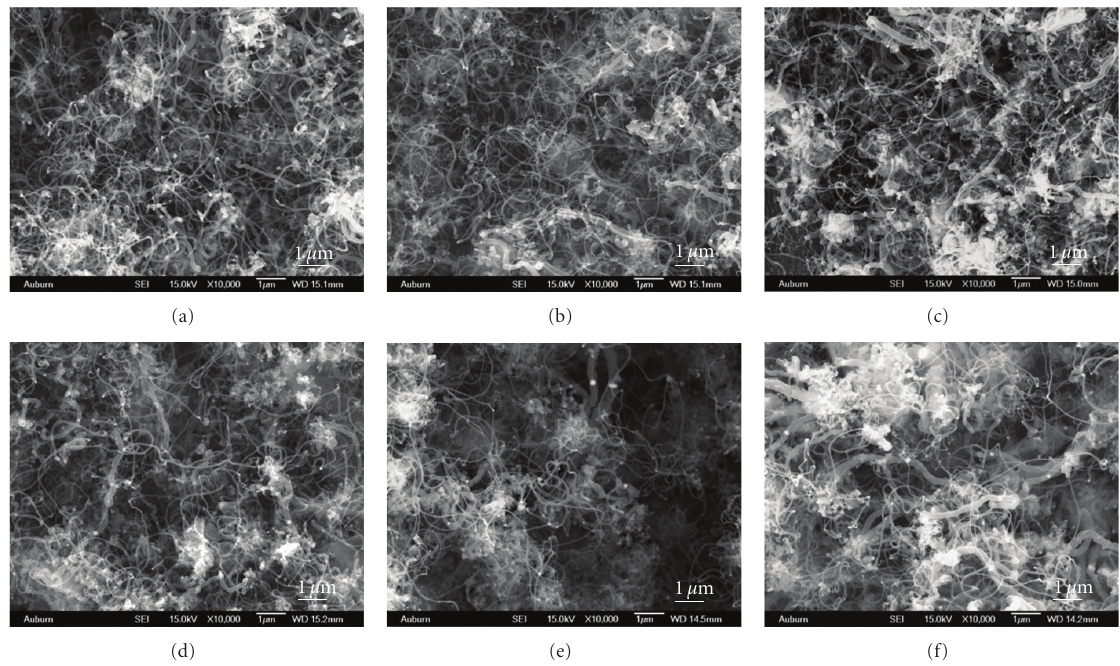
Figure 5: Synthesized CNF for e ff ects of pretreatment on foil: (a) as-received, (b) reduced at 715 ◦ C for 15min, (c) reduced at 815 ◦ C for 120min, (d) thermal faceting at 515 ◦ C, (e) thermal faceting at 715 ◦ C, and (f) thermal faceting at 815 ◦ C. Synthesis conditions: 2% C 2 H 2 , 10% H 2 , 88% N 2 , and 470 ◦ C (Table 1 (Phase